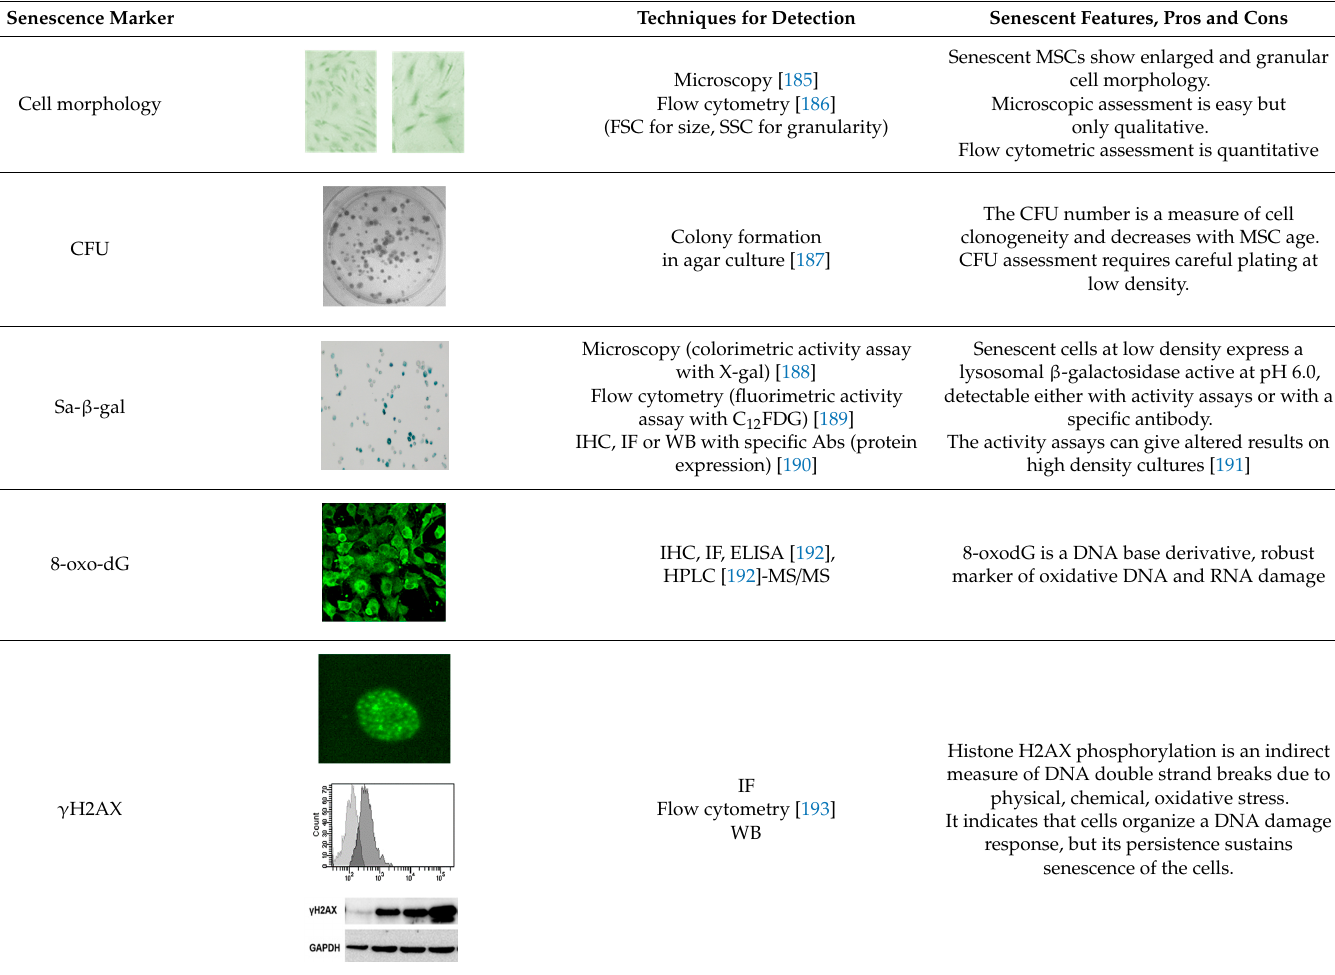
Table 1. Markers of MSC senescence and techniques most frequently used for their detection. Senescence Marker Senescence